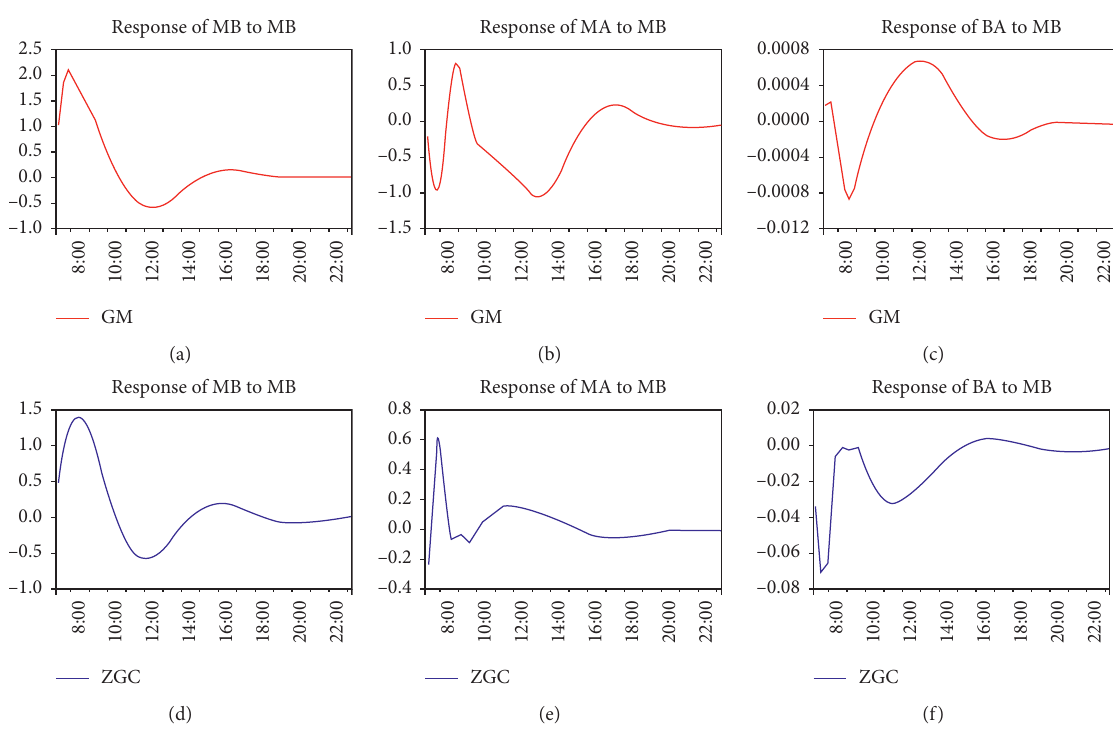
Figure 5: Response to the change in HLG metro boarding volume at 7: